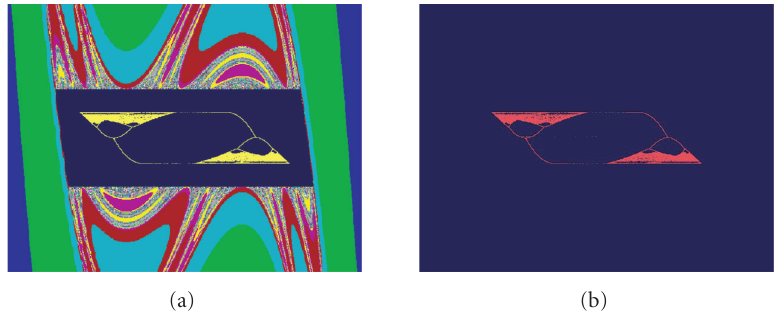
Figure 4.4. Emergence of the relaxation cycle and its